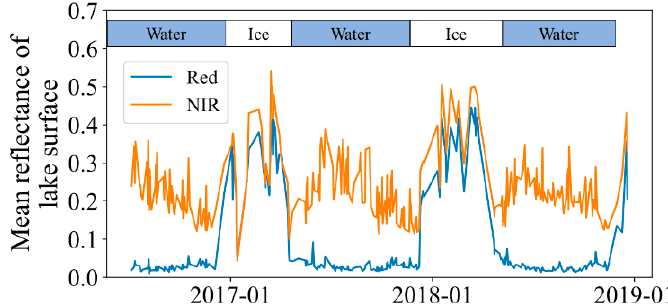
Figure 3. Mean reflectance of near infrared (NIR) and red band over surface of Silver Lake (Figure 8, Pond) lake in Maine. Two periods of water and ice are